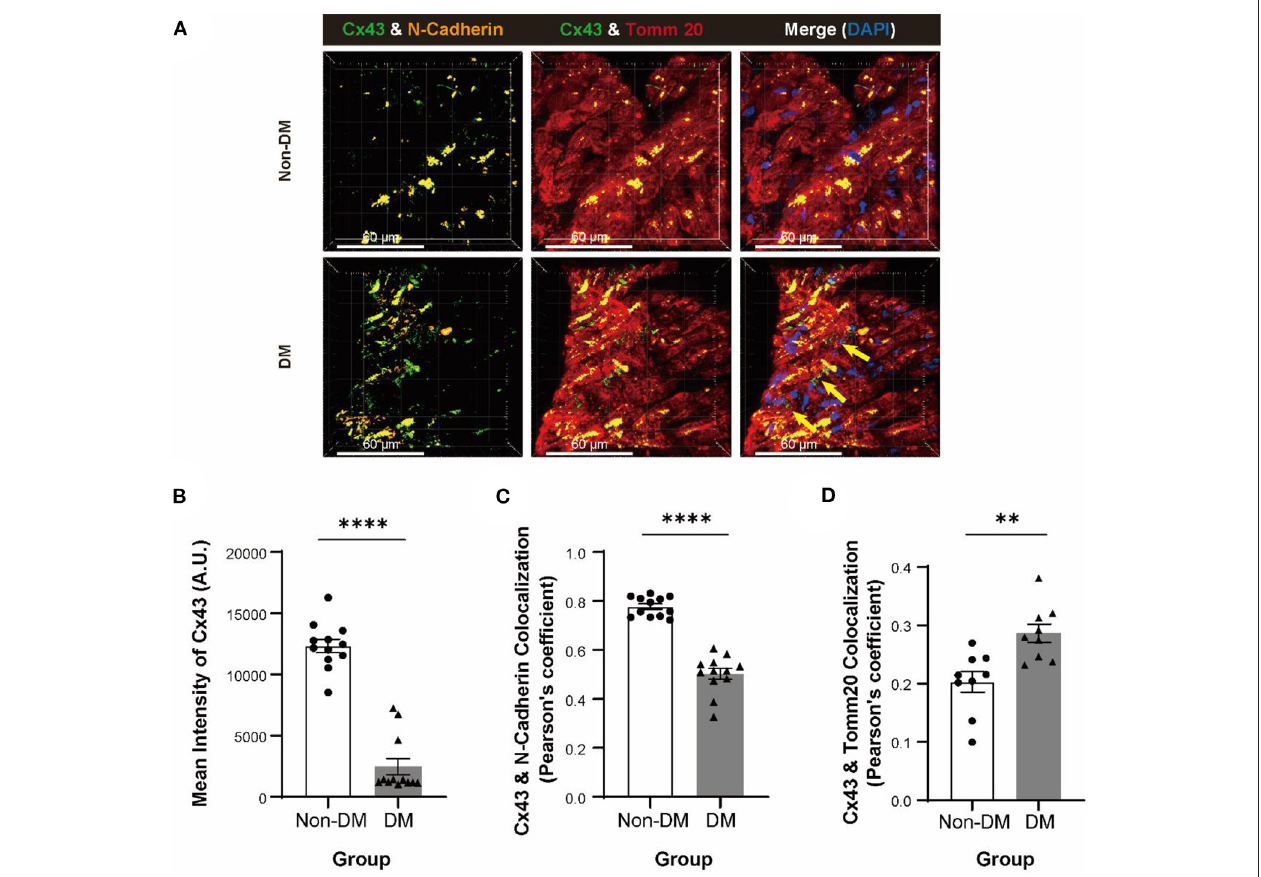
FIGURE 1 | Degradation and displacement of connexin 43 (Cx43) in myocardium of patients with diabetes mellitus (DM). (A) Immunofluorescent staining of Cx43, N-cadherin, and Tomm20 in myocardial tissue of patients with or without DM (yellow arrow: aberrant Cx43 in mitochondria, n = 3 patients per group; scale bars, 60 µ m). (B–D) Analysis of mean intensity of Cx43 [ (B) , n = 12 field views per group], colocalization of Cx43 and N-cadherin [ (C) , n = 12 field views per group] and colocalization of Cx43 and Tomm20 [ (D) , n = 9 field views per group]. Data are shown as mean ± SEM. The Student’s two-tailed t -test was used. ** P < 0.01, **** P <